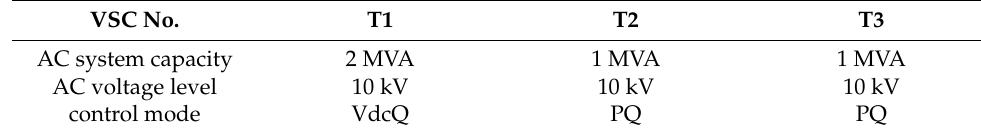
Table 2. Initial states of